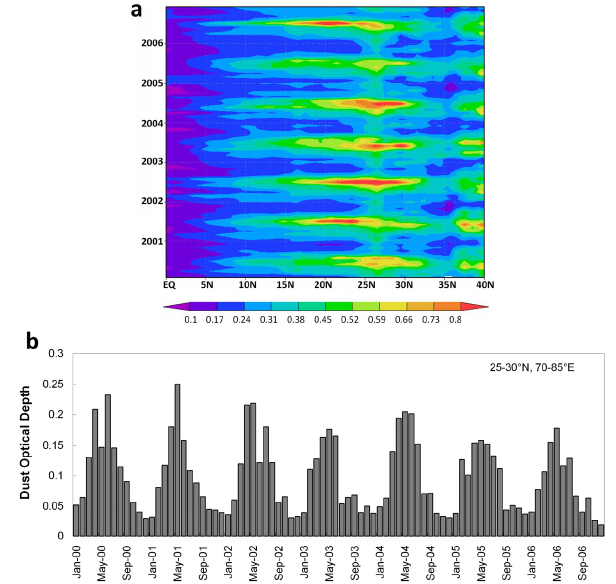
Fig. 1. (a) Inter-annual variability of MODIS AOD over India (zonal mean: 60–100 ◦ E) from 2001 to 2006; the AOD peaks during the pre-monsoon season and, (b) dust optical depth from GOCART model outputs over northern India region (25–30 ◦ N, 70–85 ◦ E).